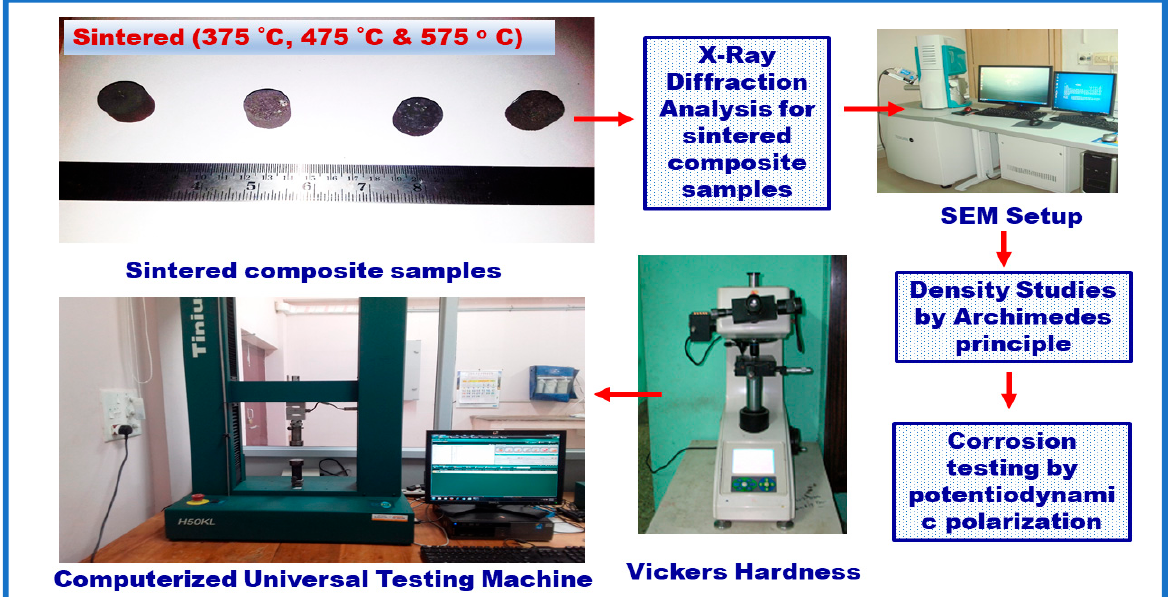
Figure 3. Characterization and mechanical properties studies for the sintered composite samples.